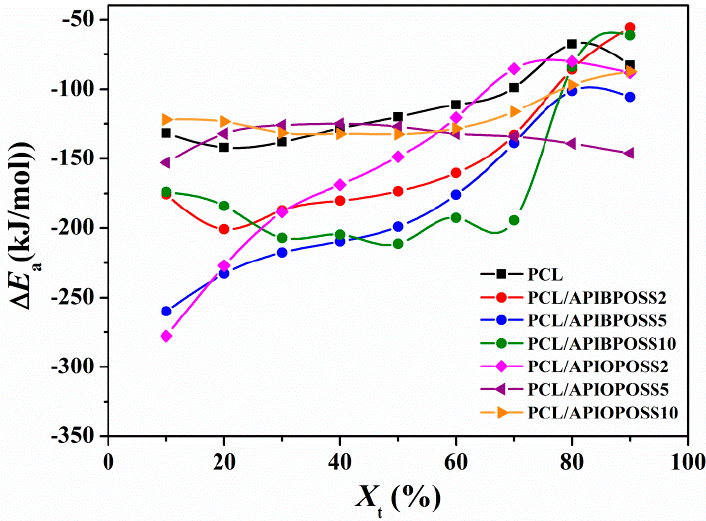
Figure 13. Dependence of the activation energy on the relative crystallinity using isoconversional analysis for PCL and PCL/POSS nanocomposites.